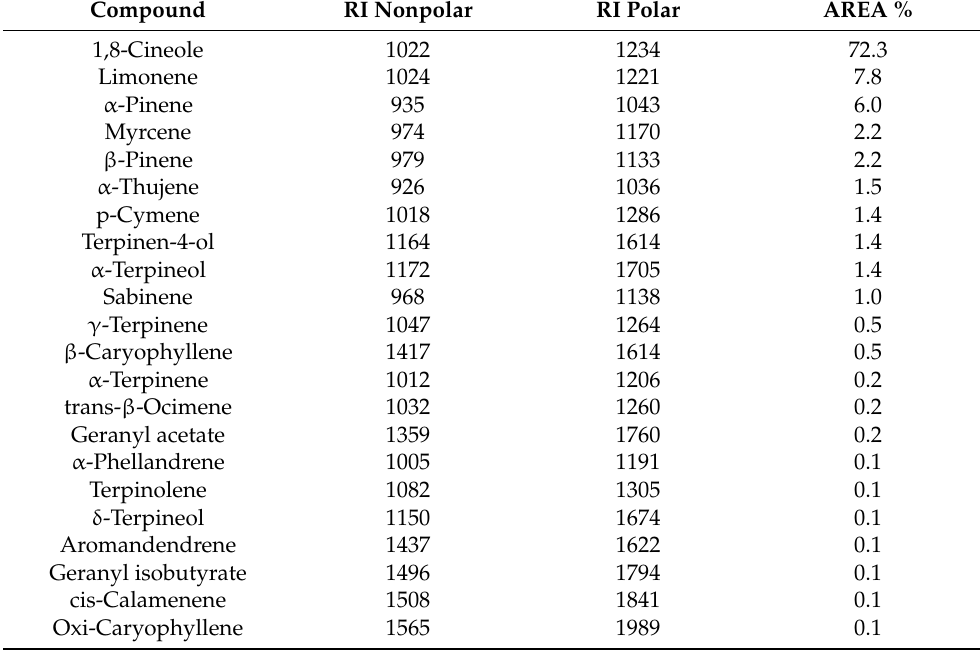
Table 1. Composition of Melaleuca armillaris essential oil analyzed by gas chromatography-mass spectrometry and flame ionization detector (GC-MS)-FID. RI: retention index. The polar column was connected to an FID, whereas the nonpolar column was connected to a MS detector.